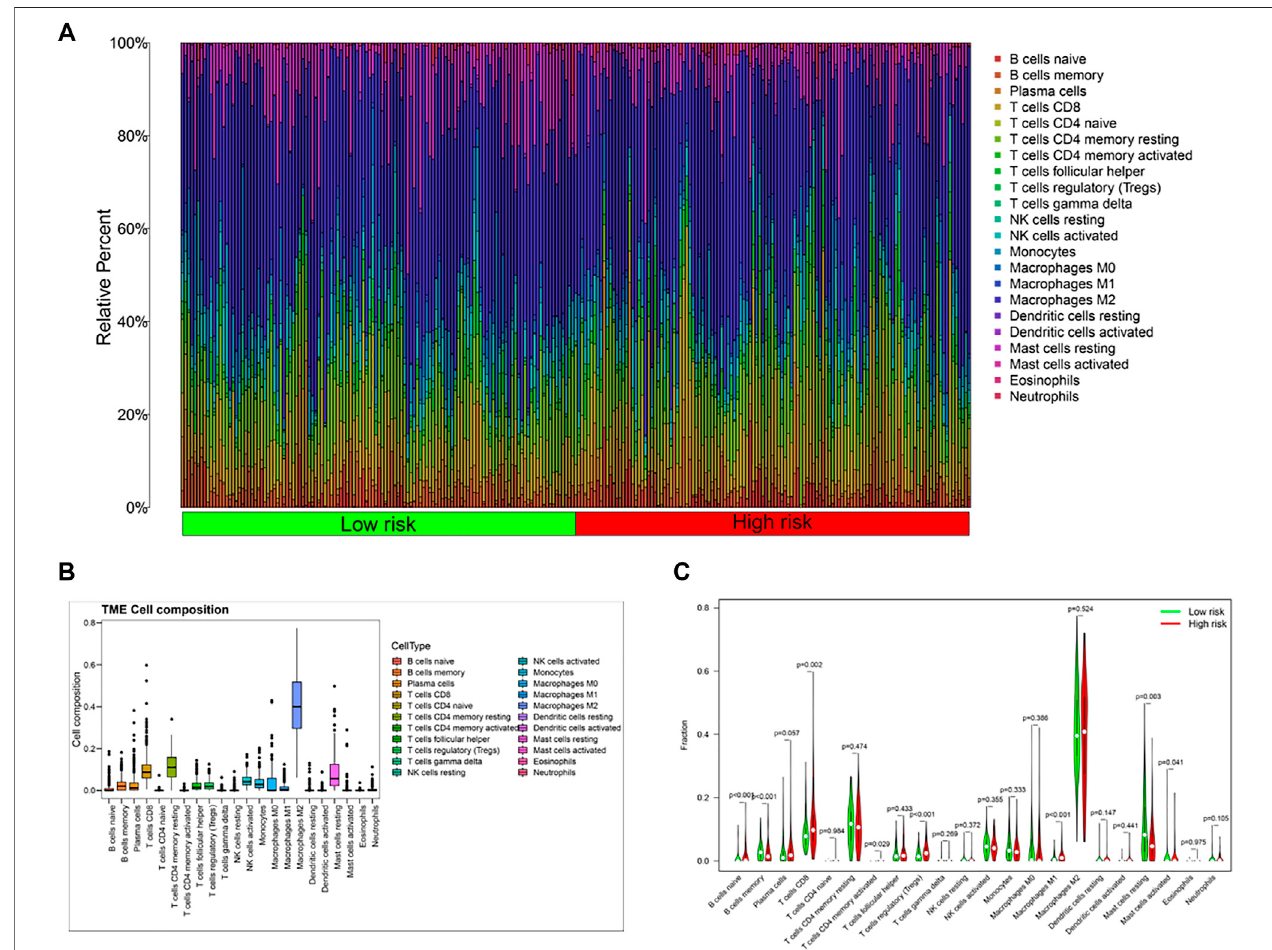
FIGURE 6 | (A,C) Differences in immune cell composition between the high-risk group and the low-risk group; (B) tumor microenvironment immune cell composition in KIRP